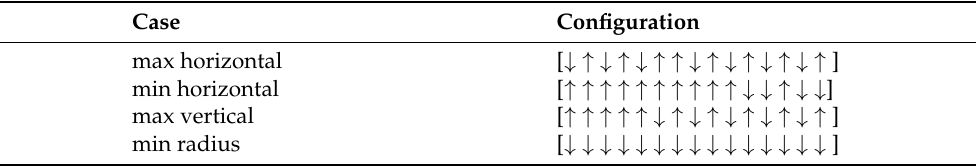
Table 7. Resulting unit orientations for each unit in sequence from left to right targeting each of the four cases described in Table 6. Note that in all four cases, if each is reversed, they still produce the same result, though the results will be visually reflected about the x -axis.